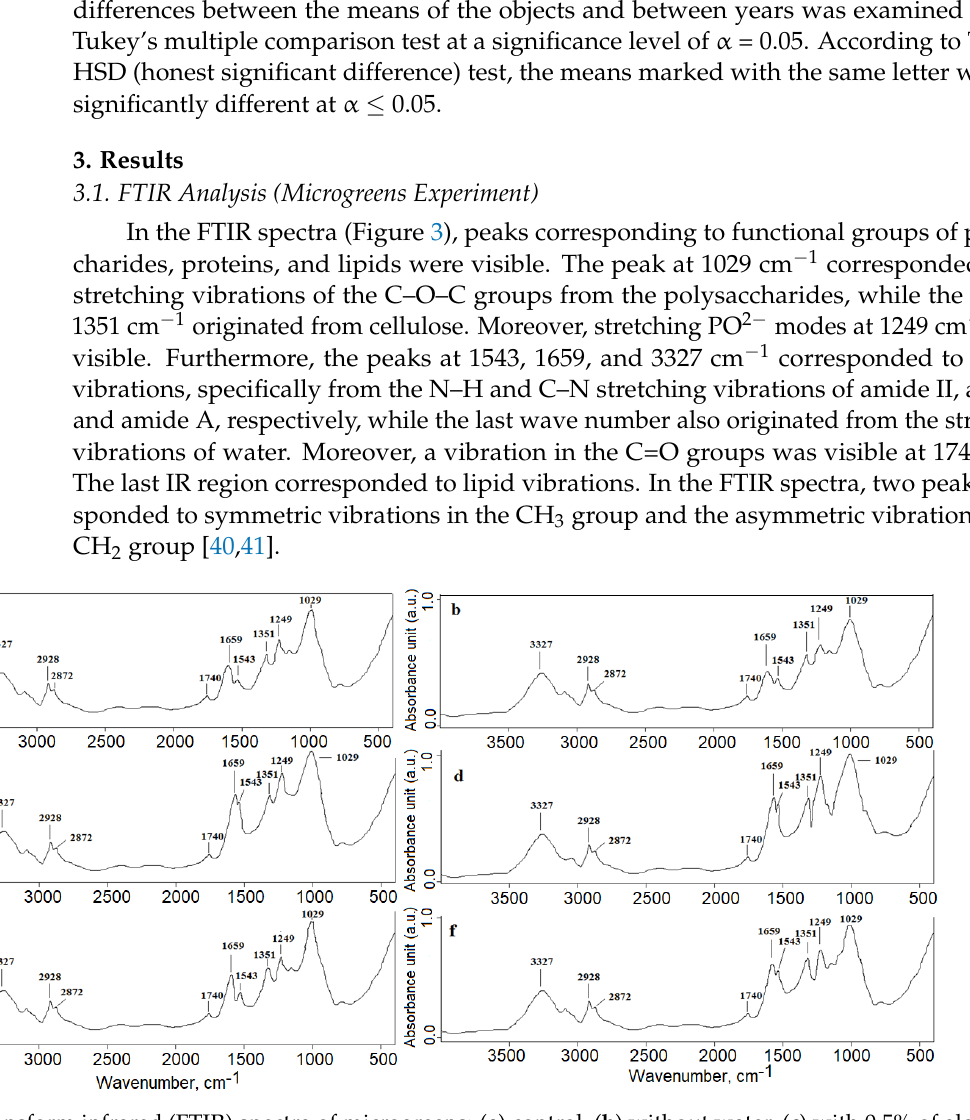
Table 3. Moisture characteristics of the months of the growing season (2016–2018) depending on the value of the Sielianinov hydrothermal coefficients.